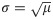
Relationship between mean and standard deviation of sales quantities by category: cheese (red) and hair-styling (blue).Solid, dashed and dotted line show σ=μ, σ = 0.26μ, and σ = 0.05μ respectively.